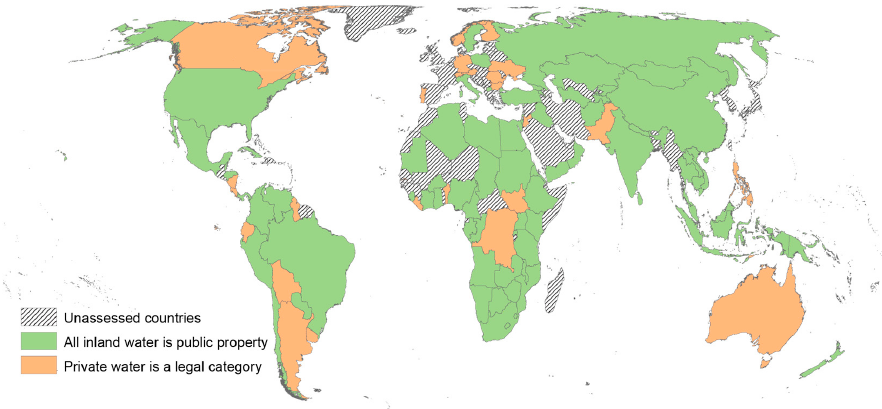
Figure 2. Legal provision for water as public property and private property.